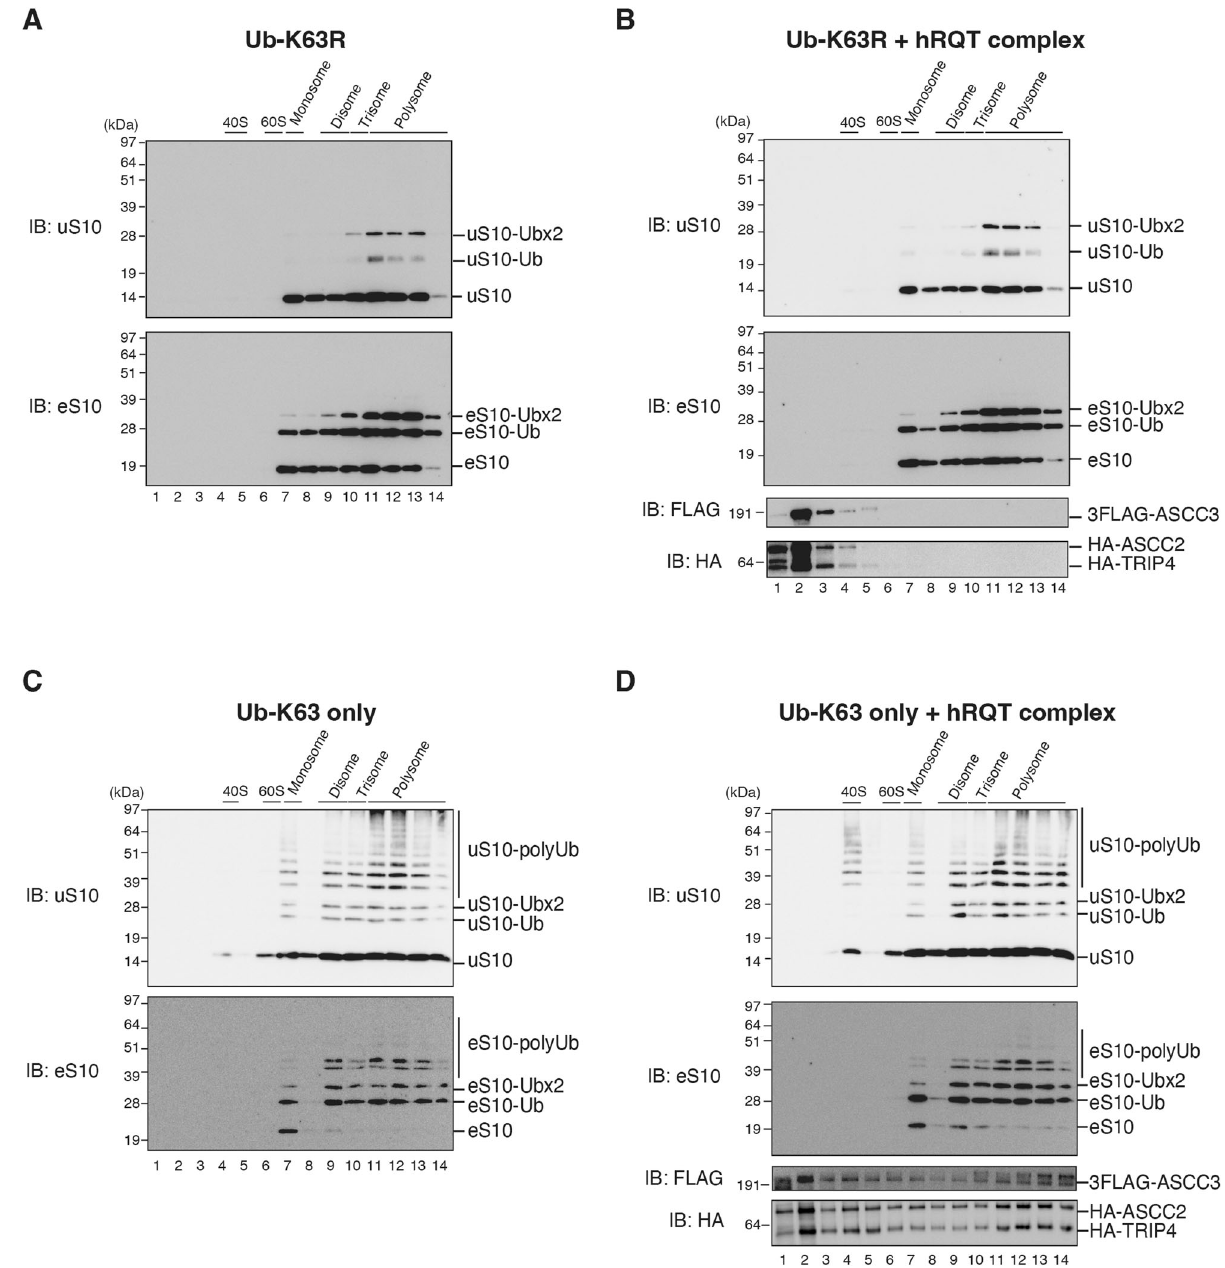
Fig. 6 | The hRQT complex dissociates collided ribosomes with K63-linked polyubiquitin chains on uS10. A – D In vitro hRQT complex-mediated subunit disassociation assay of K63-linked polyubiquitinated ribosomes. Isolated RNCs generated by XBP1u staller mRNA were ubiquitinated by ZNF598 with either Ub- K63R ( A , B ) or Ub-K63only ( C , D ). The ubiquitinated RNCs were incubated with